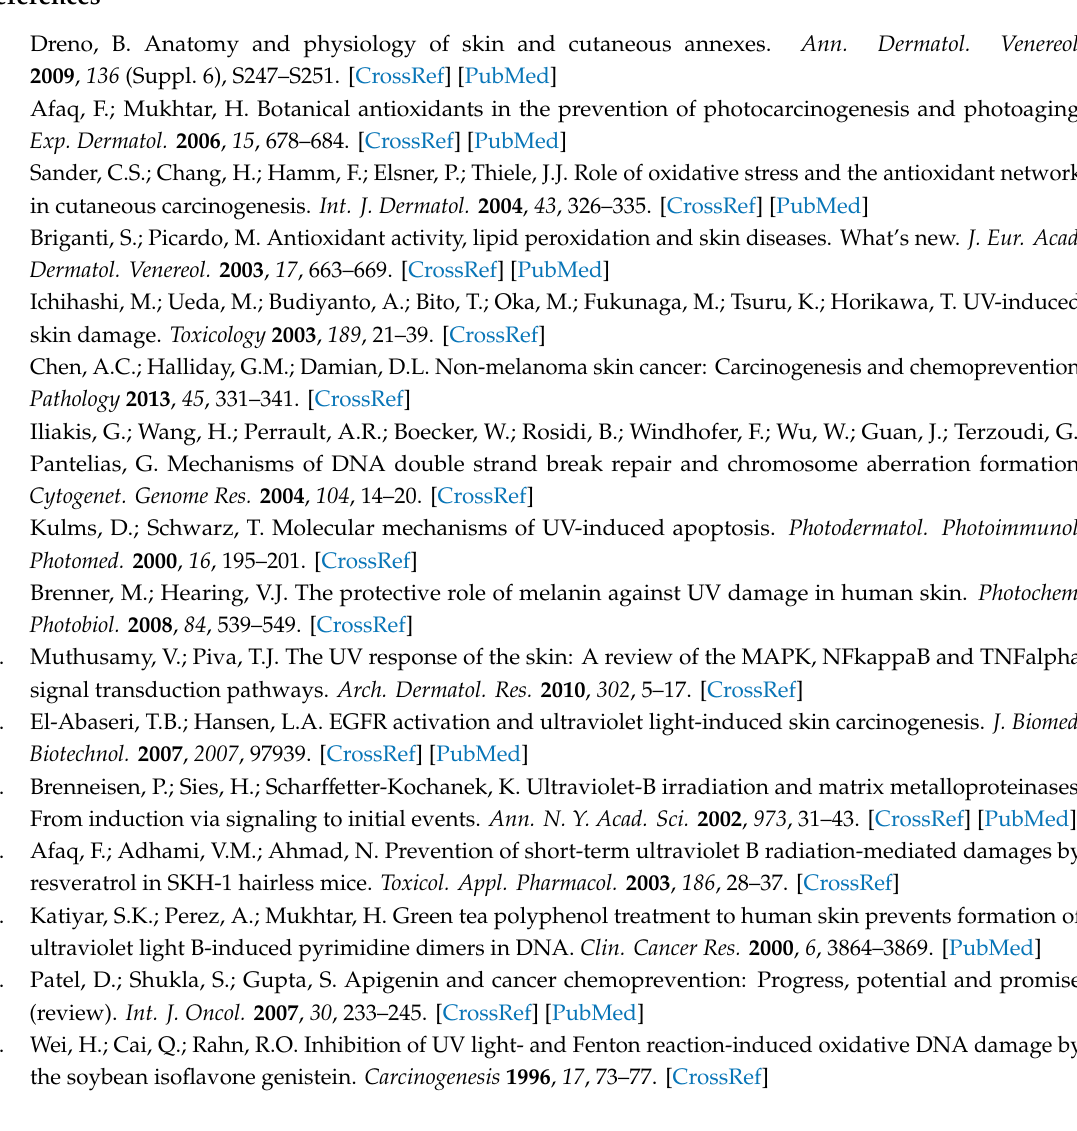
Figure S1: Representative population plots of depolarized cells (A–D), apoptotic cells (E–H), and activated H2AX (I–L) obtained using the Muse Cell Analyzer. There are included plots from control of nonirradiated HaCaT cells (A,E,I), control of irradiated cells at 1200 J / m 2 (B,F,J), irradiated cells at 1200 J / m 2 in the presence of F1 (200 µ g / mL) (C, G, K), and irradiated cells at 1200 J / m 2 in the presence of F2 (200 µ g / mL)